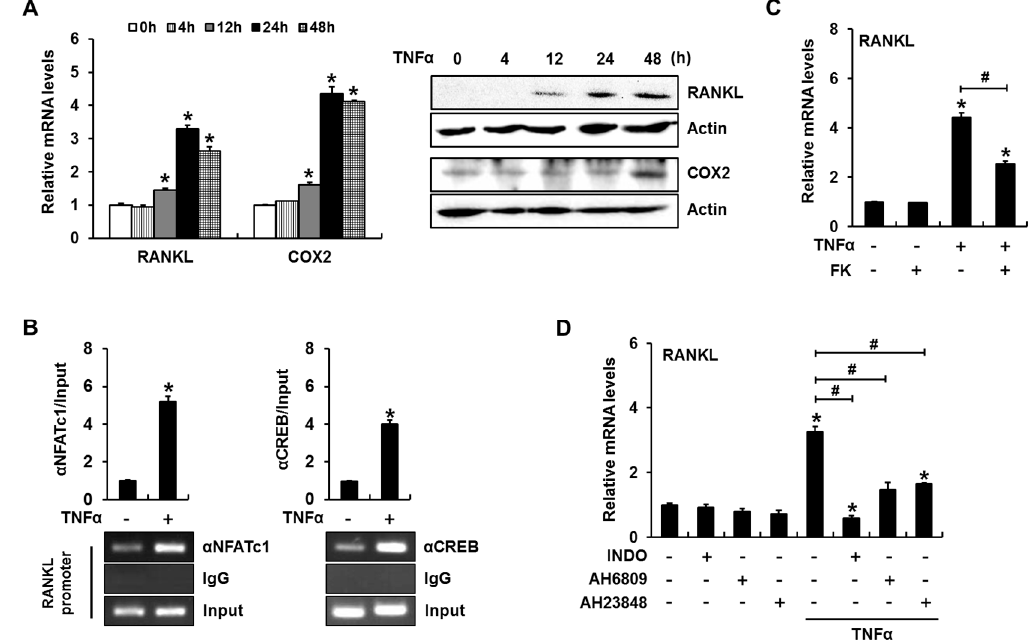
Figure 6. PGE 2 production and NFAT activation are necessary for TNF α -induced RANKL expression in primary cultured mouse calvarial cells. ( A ) TNF α enhanced the expression of RANKL and COX2. Calvarial cells were incubated in the presence of TNF α for the indicated time periods and subjected to RT-PCR and western blot analyses; ( B ) ChIP assays revealed that TNF α increased NFATc1 and CREB binding to their cognate binding sites in the mouse RANKL promoter; ( C ) A calcineurin/NFAT signaling inhibitor suppressed TNF α -induced RANKL expression. Calvarial cells were incubated for 24 h in the presence of FK506 and TNF α ; ( D ) Treatment with a COX2 inhibitor or PGE 2 receptor antagonists suppressed TNF α -induced RANKL expression. (* p < 0.05, compared to control; # p < 0.05).